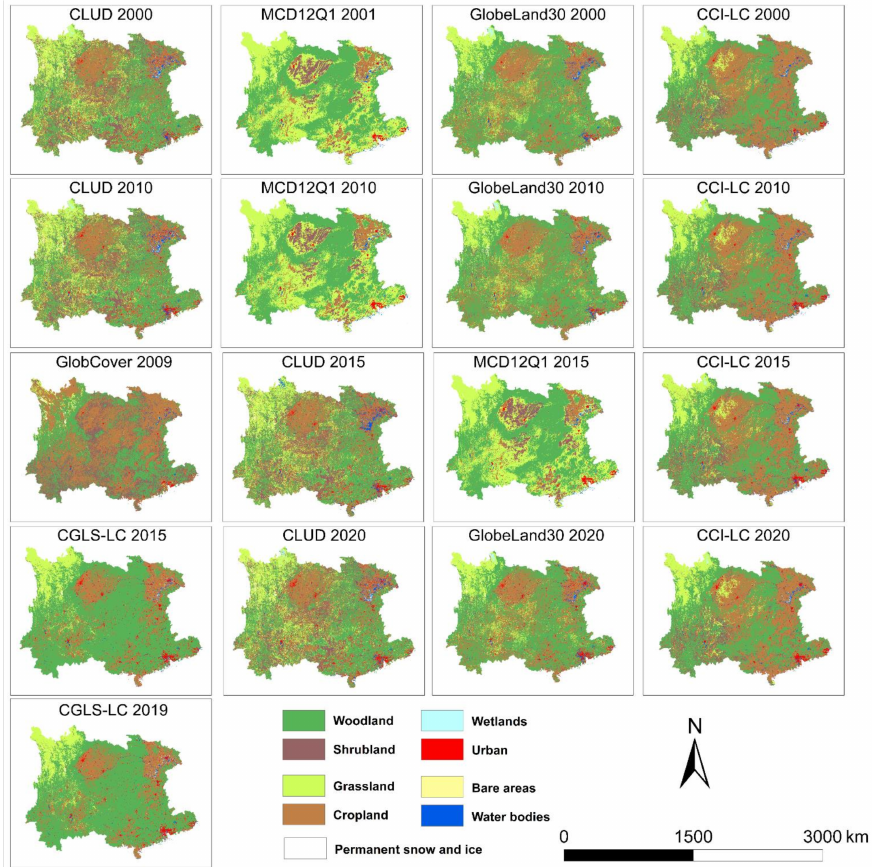
Figure 2. Spatial patterns of the five global LC products and the CLUD dataset in a unified, nine-class scheme in southern China over